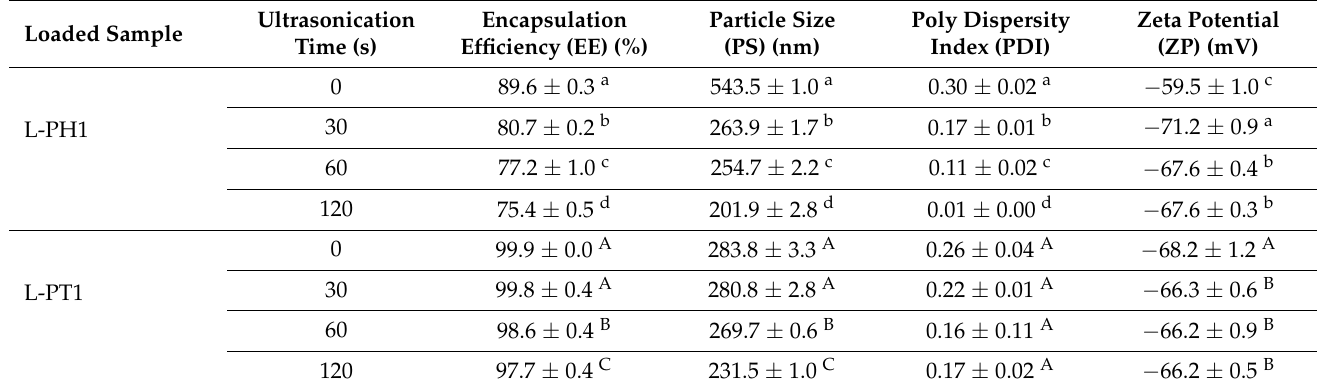
Table 3. Encapsulation efficiency (EE), particle size (PS), polydispersity index (PDI) and zeta potential (ZP) of SFPH- and SFPT-loaded liposomes treated with ultrasound assisted process